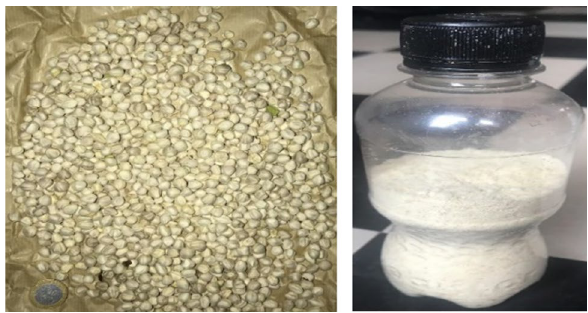
index (Table 2) ranging from Class 0 (Igeo = 0, unpolluted) to Class 6 (Igeo > 5, extremely polluted). The highest class (Class 6) reflects at least a 100-fold enrichment factor above background values.